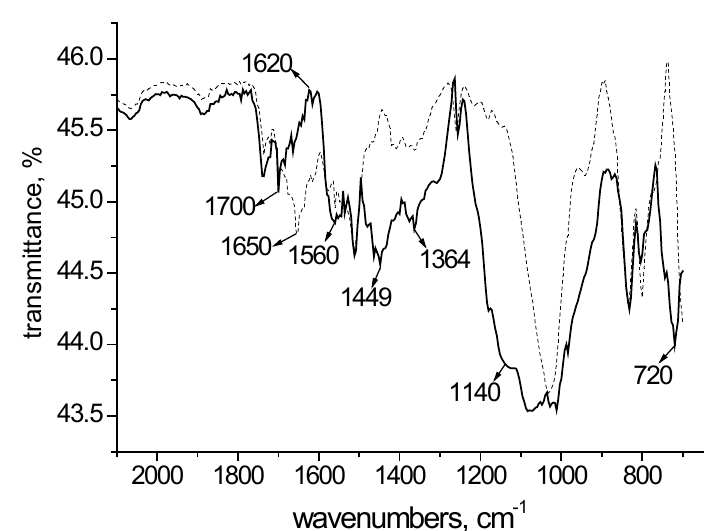
Figure 5. FTIR spectra for primary (dotted line) and functionalized (synthesis 7, solid line) SWCNTs. Table 2. Response and recovery times for 100 ppm NO